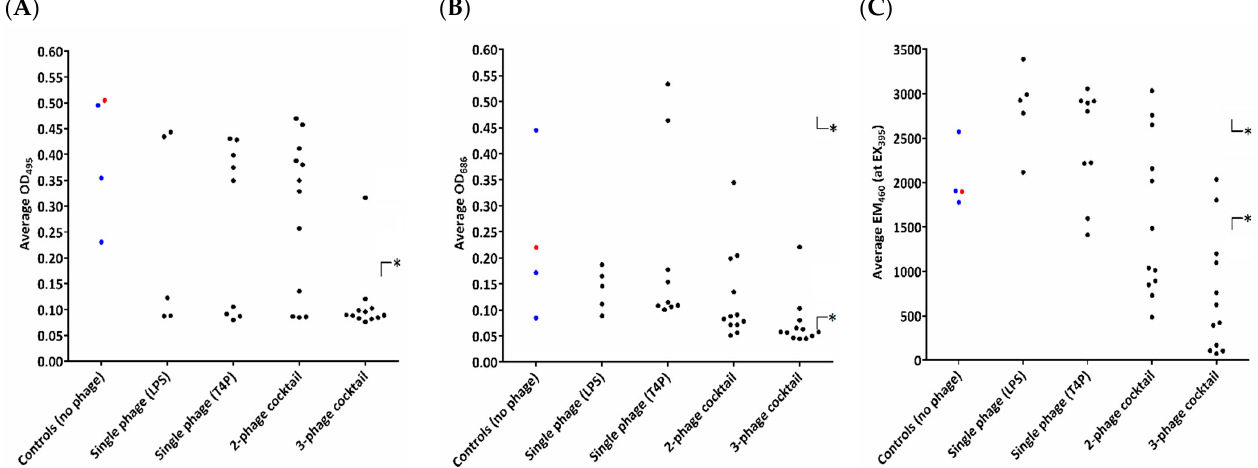
Figure 3. Changes in extracellular virulence factor production in emerging phage-resistant PAO1 clones versus the wild-type PAO1 sessile population: ( A ) changes of elastase in the growth medium; ( B ) changes of pyocyanin in the growth medium; and ( C ) changes of pyoverdin in the growth medium. Untreated sessile PAO1 was used as a control. The dots represent the measured values of particular clones: wild-type PAO1 clones (red dot); control sessile clones (blue dots); and mutants selected by phages (black dots). Statistically significant difference compared to the phage-untreated pool (* p < 0.001, ANOVA test).